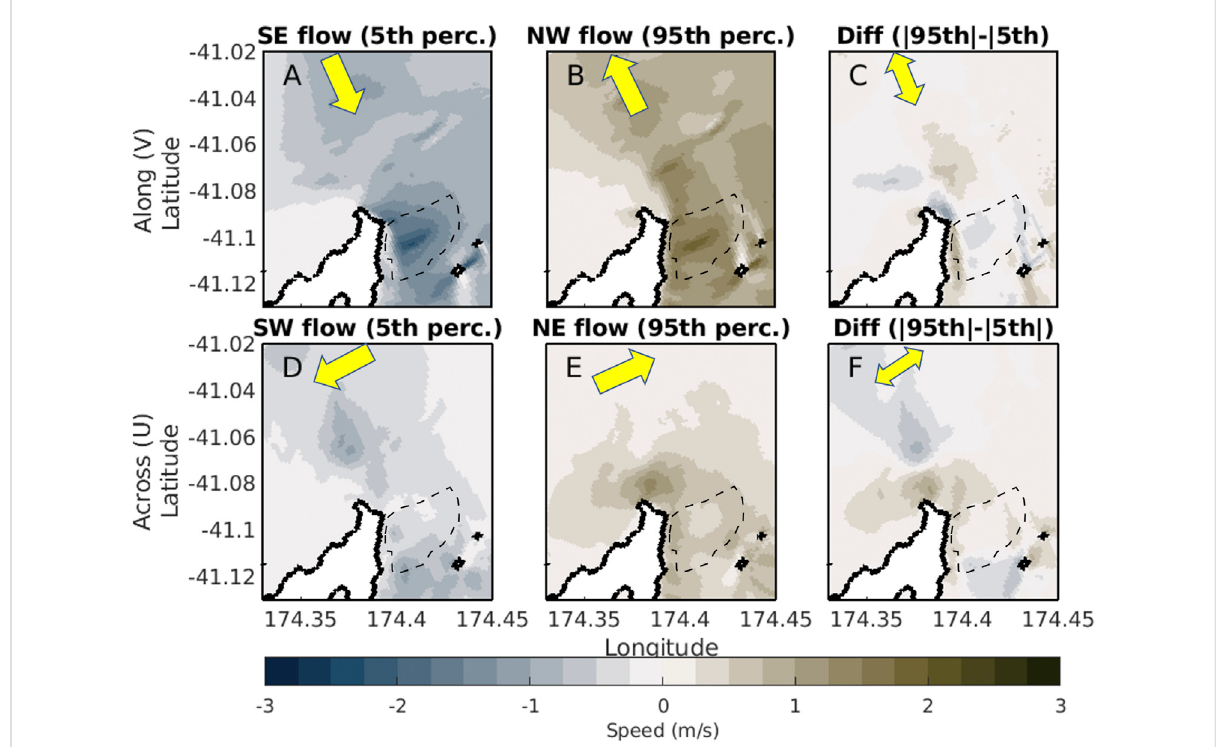
FIGURE 8 The 5th and 95th percentile for components of near-bottom currents along the entrance to QCS [top panels (A, B) ] and into/out of QCS [bottom panels (D, E) ]. The difference between the 95th and fi fth percentile for the u and v components to velocity is shown in panels (C, F) . Brown indicates a stronger positive (northeastward and northwestward) fl ow and blue indicates a stronger negative (southeastward and southwestward) fl ow. The yellow arrows at the top left of each panel indicates the direction of the fl ow that is being shown in each panel [panels (A-C) show currents fl owing along the entrance of outer QCS; panels (D-F) show currents fl ow across the entrance of QCS]. Black dashed lines outline the area where the bedforms are located (see Figure 1 for